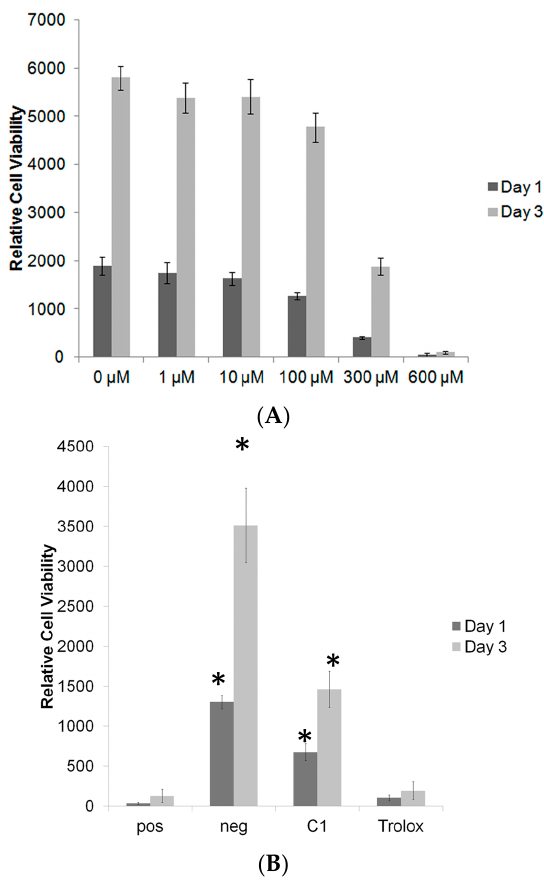
Figure 4 . ( A ) Toxicity of different concentration of H 2 O 2 on MC3T3-E1 ( B ) Effect on MC3T3-E1 protection against H 2 O 2 (pos control) by C1 and Trolox (both at 25 µM), * indicates p < 0.05 compared to positive control. Data expressed as mean ± standard deviation.